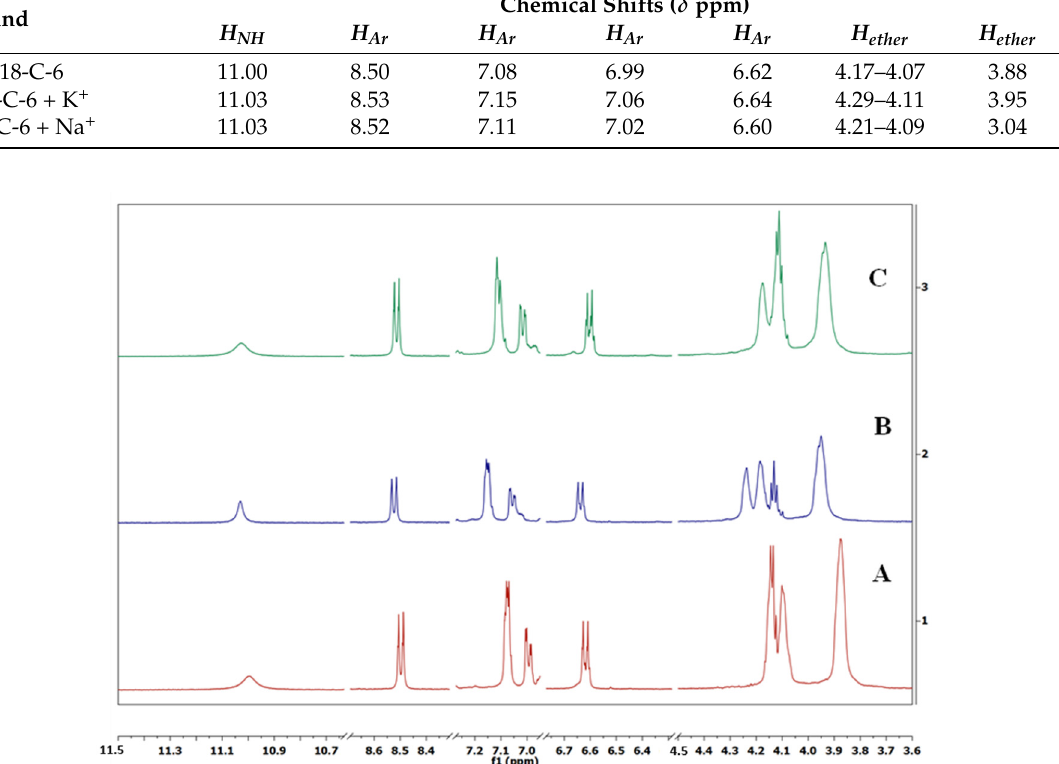
Table 1. Changes in chemical shifts upon complexation of bis- NBD-DB18-C-6 with K + and Na + cati- ons.